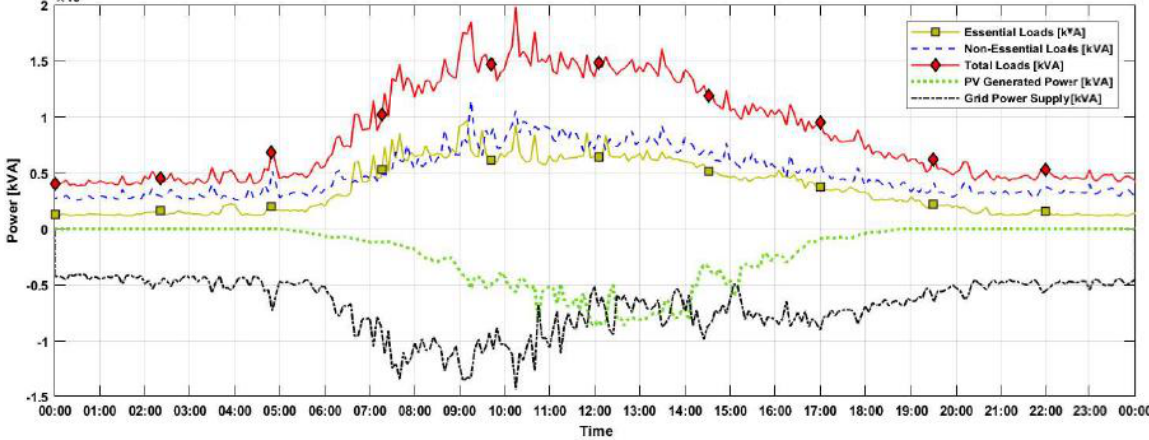
Figure 12. The behavior of MCAST micro-grid with increased PV capacity on a typical weekday.